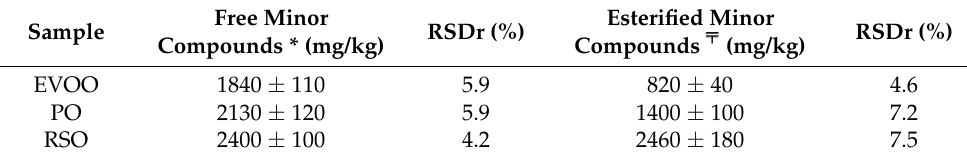
Table 1. Repeatability values for the optimized SPE-GC-FID